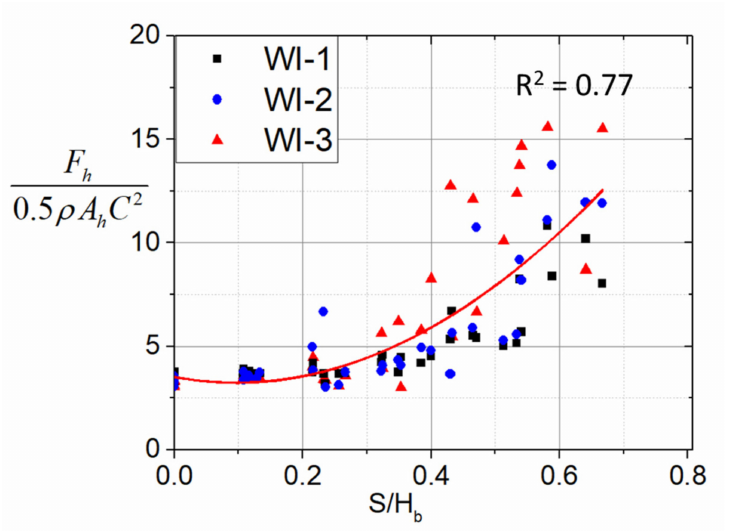
Figure 22. Variation of horizontal force coefficients at three wave impact scenarios for different S/H b ratios.